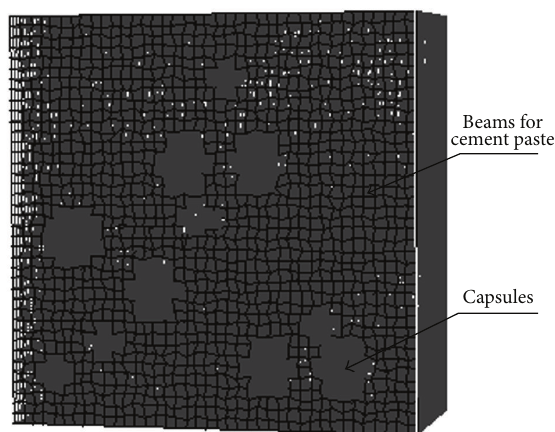
Figure 13: Cross section of the lattice constructed by beam elements for the sample with capsules.